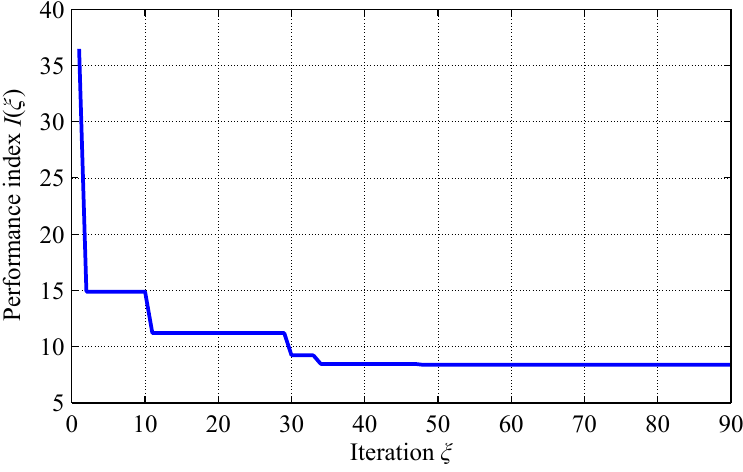
Figure 4. Evolution of performance index I ( ξ )